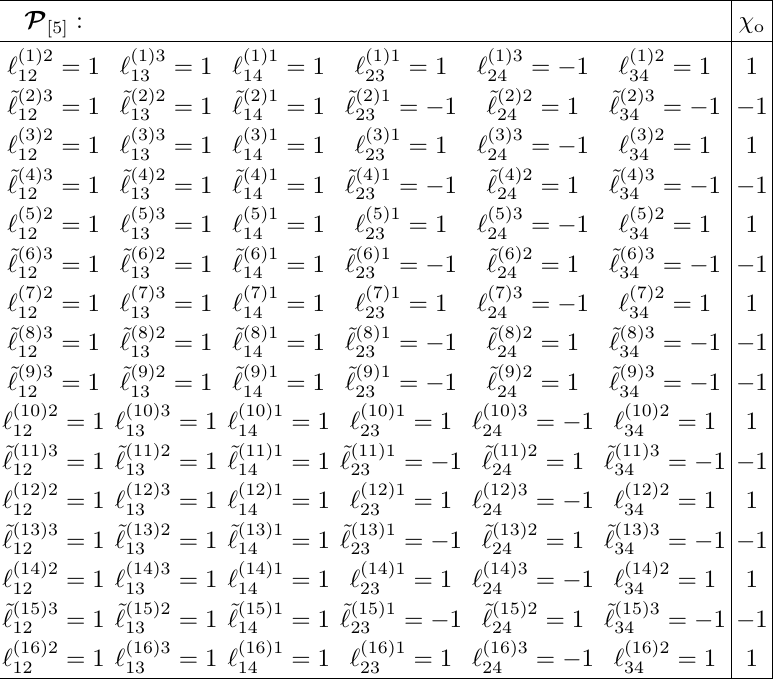
Table 15 . Non-vanishing ‘ , e ‘ , and (cid:31) o Values For Representation P